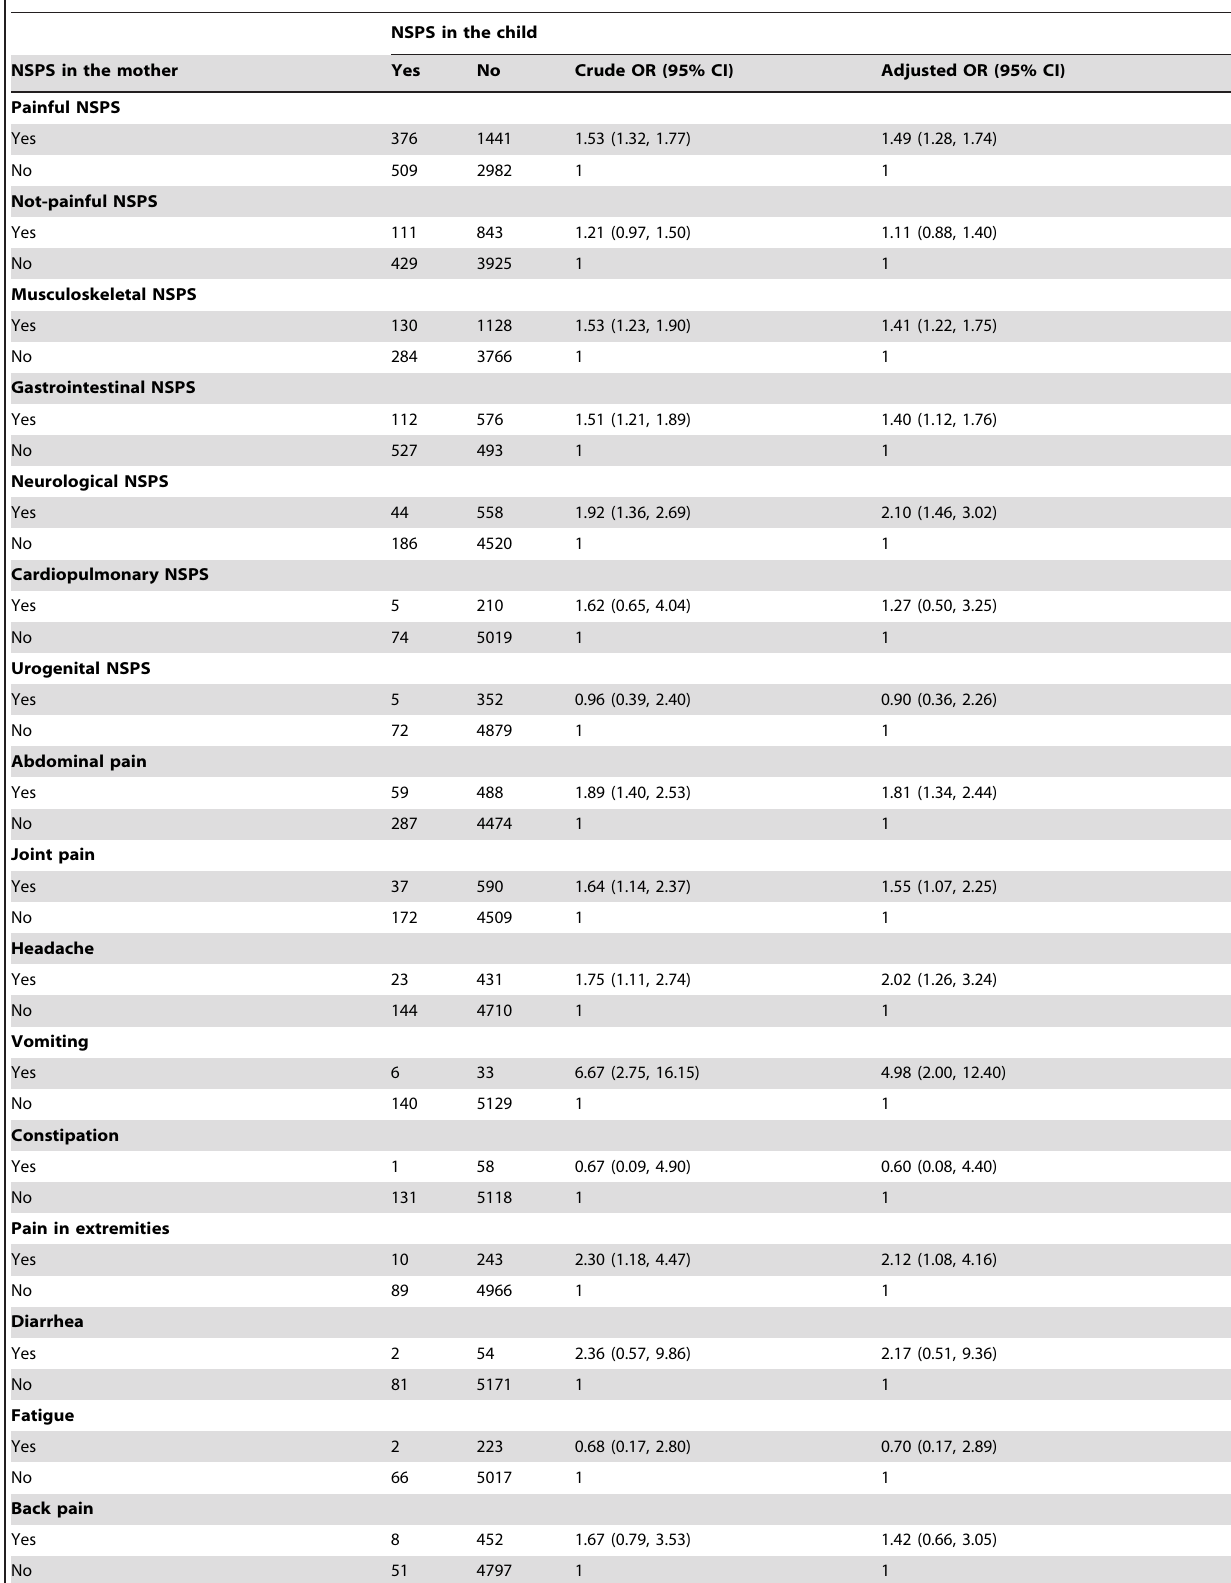
Table 6. Associations between consultation for specific symptoms in mothers & children.